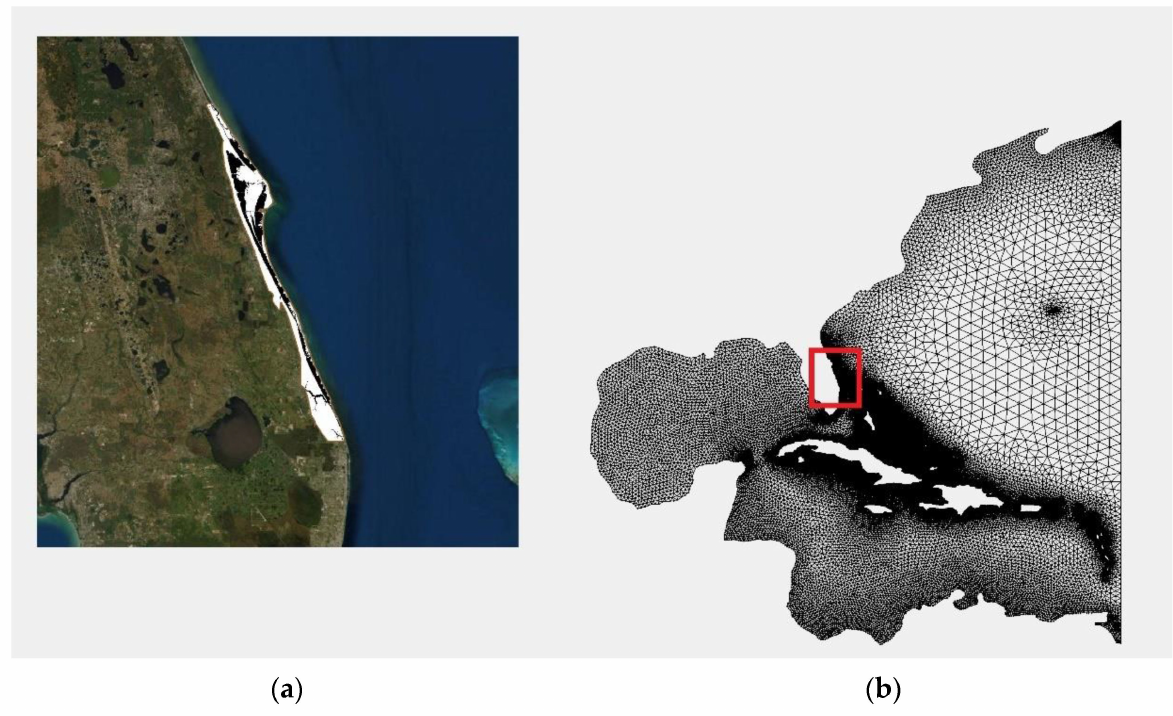
Figure 3. Meshes used in the study. ( a ) highlighted Indian River Lagoon fine mesh, ( b ) parent East Coast coarse